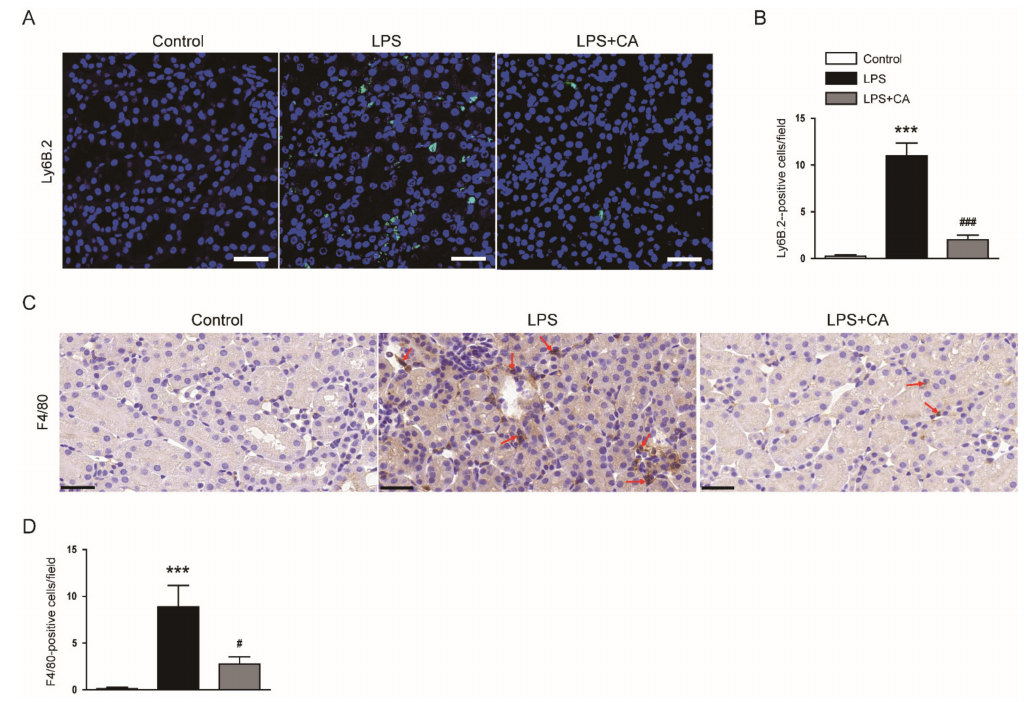
Figure 5. Effect of carnosic acid on neutrophil and macrophage infiltration. ( A ) IF staining for Ly6B.2 (green) on kidney sections. To stain nuclei, DAPI (blue) was used. Scale bar: 40 µ m. ( B ) Number of Ly6B.2-positive cells. ( C ) IHC staining for F4/80 on kidney sections. Red arrows indicate positively stained cells. Scale bar: 30 µ m. ( D ) Number of F4/80-stained cells per field. n = 8 per group of mice. # p < 0.05 and *** p < 0.001 versus control. ### p < 0.001 versus